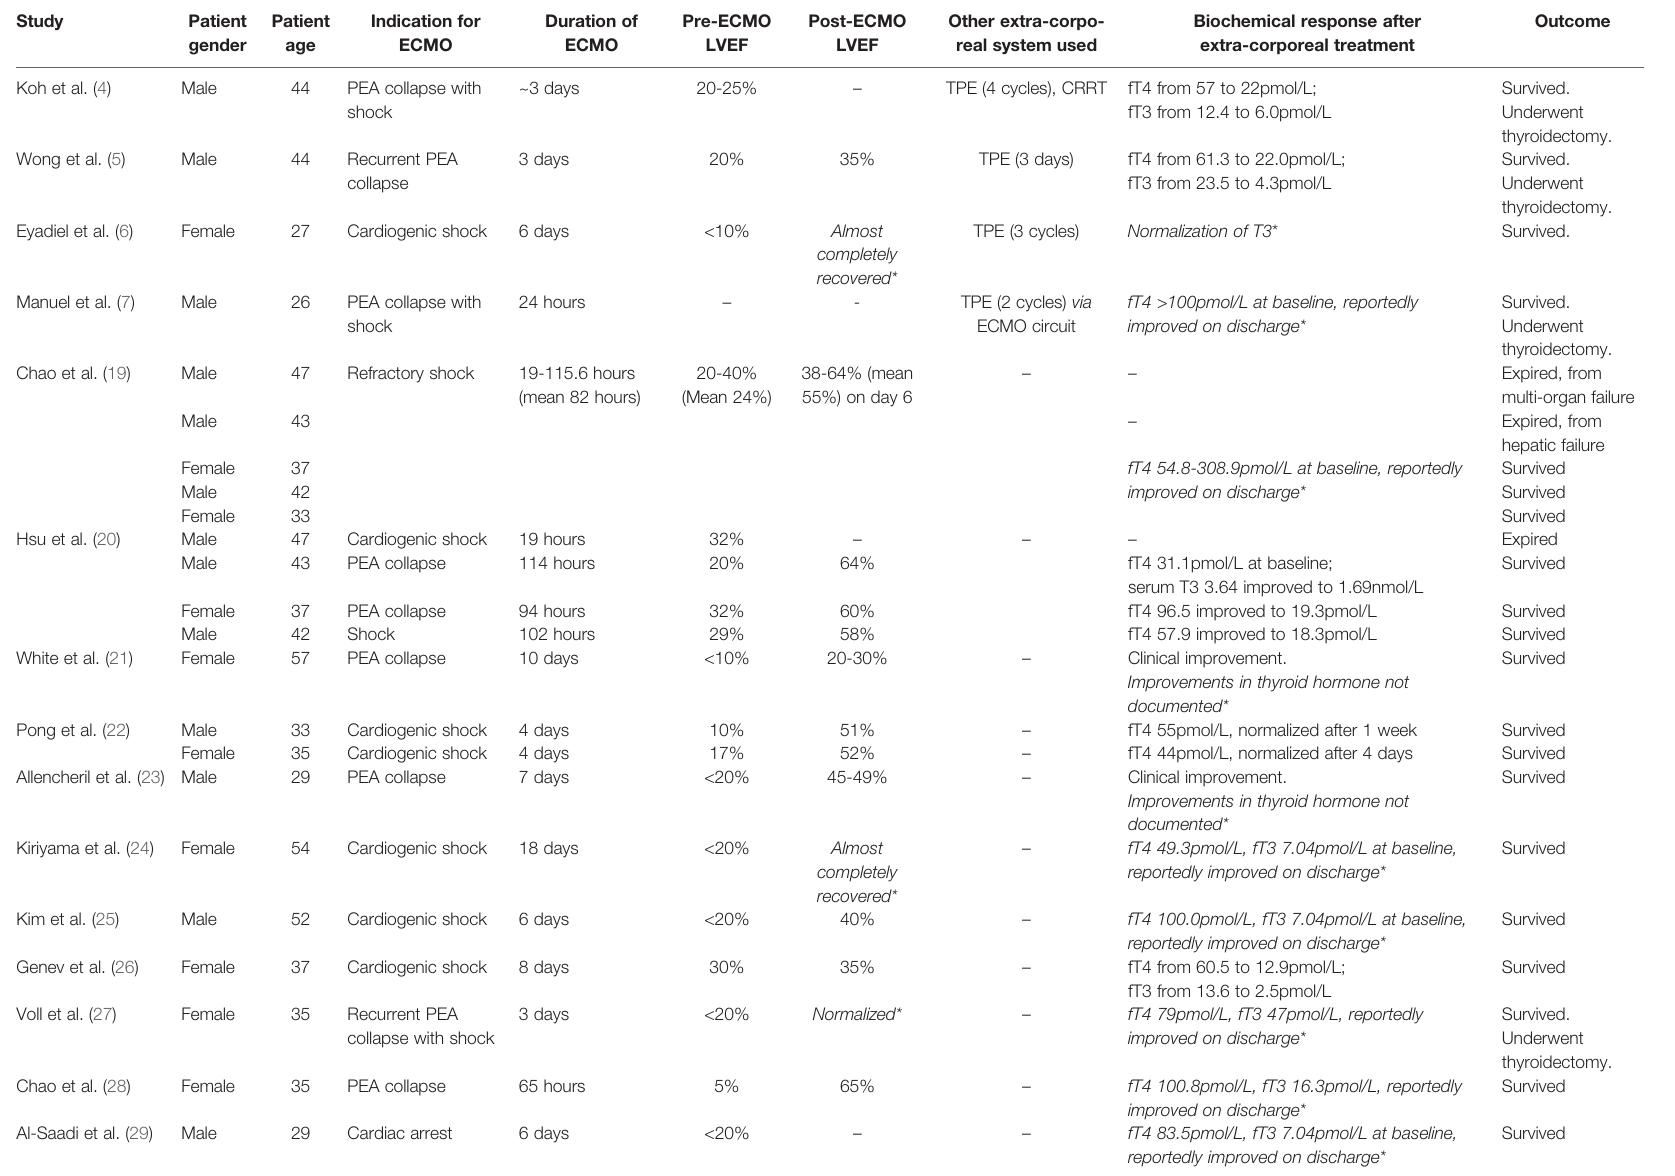
TABLE 1 | Summary of cases with use of ECMO and other extra-corporeal systems in patients with severe thyrotoxicosis or thyroid storm.